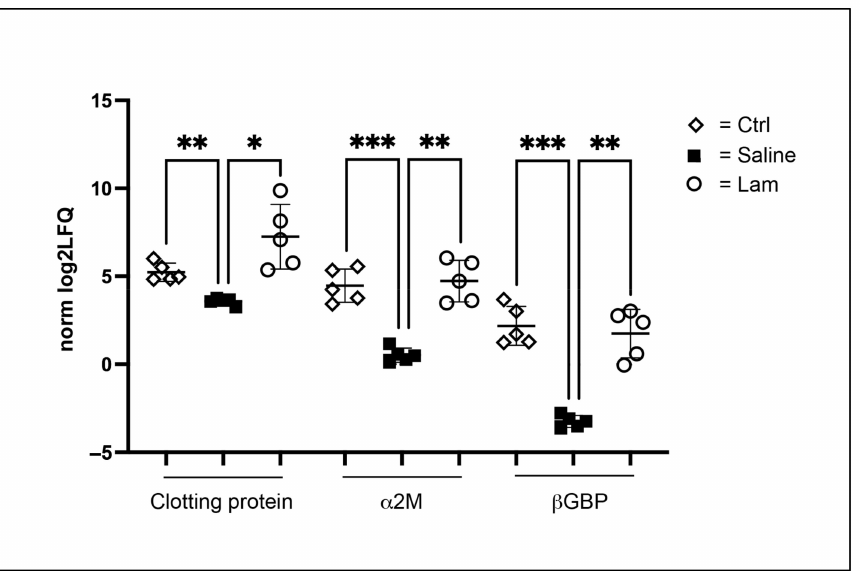
Figure 5. Highly upregulated plasma proteins after laminarin injection compared to saline injection. Statistical analyses were performed with a one-way ANOVA test, p -value < 0.0332 (*), <0.0021 (**) and <0.0001